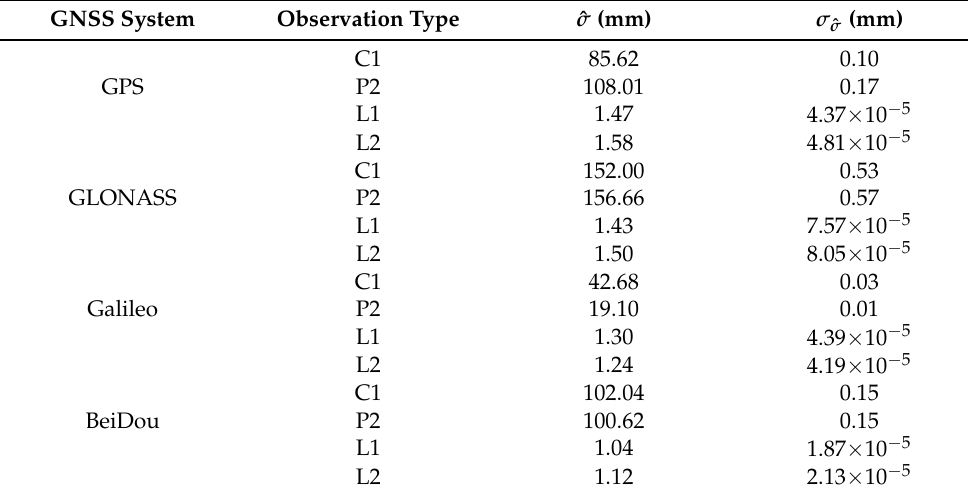
Table 2. Standard deviation of the phase and code observations and their precisions for each system, for Trimble NETR9 receiver over a zero baseline.